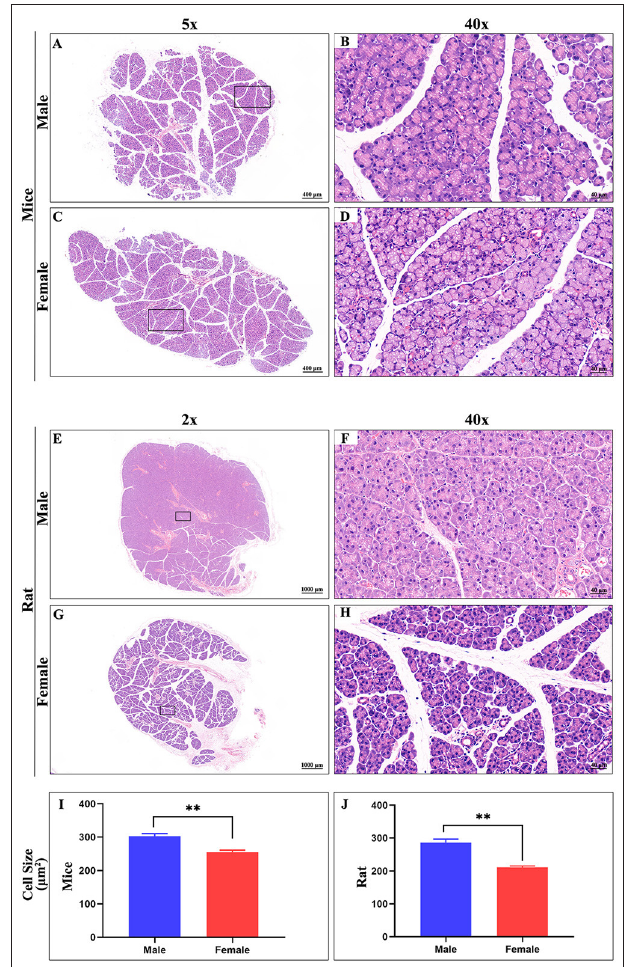
FIGURE 8 | Hematoxylin-eosin stain of ELG. (A,C) Representative images of a whole ELG (50 × microscope, scale bar = 400 µ m) from mice ( A , male; C , female). (B,D) Local amplification (400X microscope, scale bar = 40 µ m) of panels on the (A,C) , respectively. (E,G) Representative images of a whole ELG (20 × microscope, scale bar = 1000 µ m) from rats ( A , male; C , female). (F,H) Local amplification (400 × microscope, scale bar = 40 µ m) of panels on the (E,G) , respectively. Average cell size in Hematoxylin-eosin stain images of ELG sections from mice (I) and rat (J) . The values are presented as the means ± SEM, ** p < 0.01